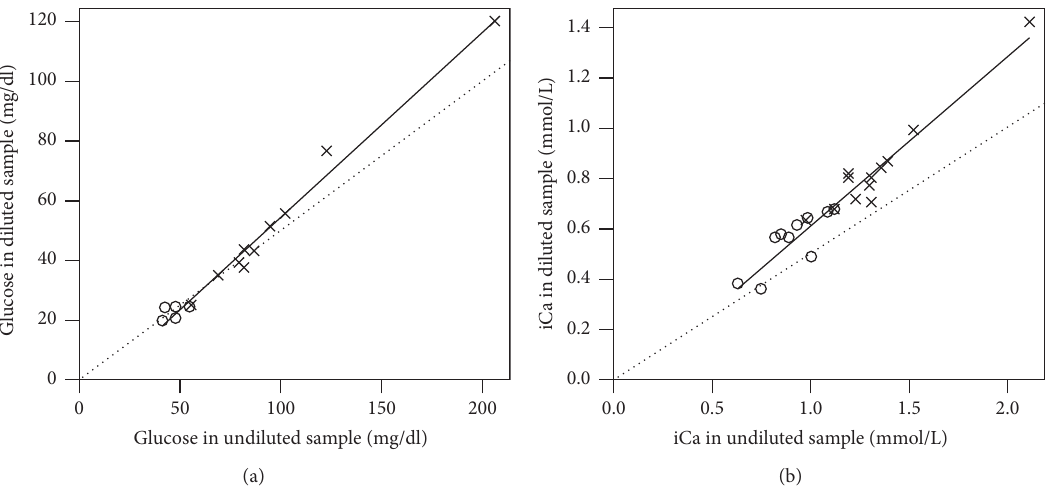
Figure 1: Linear regression of eastern box turtle ( Terrapene carolina carolina ) (x) and marine toad ( Rhinella marinus ) (o) samples (solid line) versus expected (dashed line) for (a) glucose and (b) ionized calcium. Linear regression slopes and nonzero intercepts for glucose were 0.62 and − 7.6, respectively, and for ionized calcium were 0.68 and 0.060, respectively.